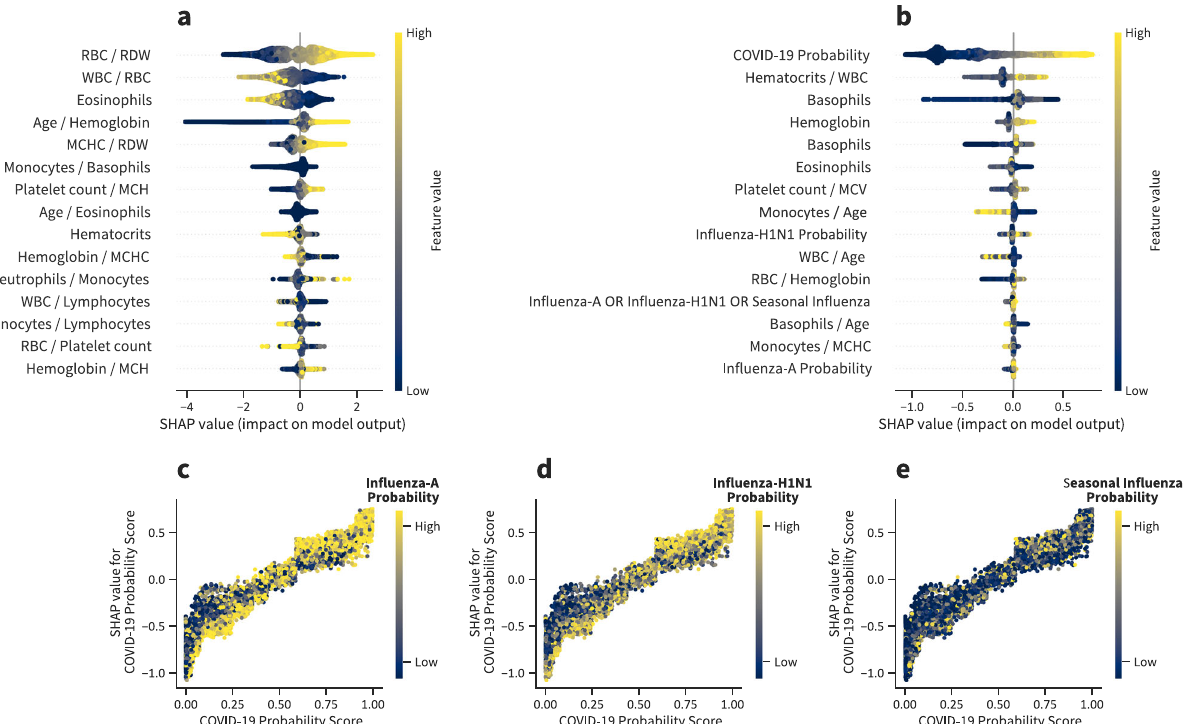
Fig. 7 Learned analyte patterns and disease prediction relationships. a SHAP Summary plot for the COVID-19 specialized model. b SHAP Summary plot for the stacking model, which combines different specialized models and CBC patterns. c Partial dependence plots with the relationship between COVID-19 specialized model's predictions and In fl uenza-H1N1. d Partial dependence plots with the relationship between COVID-19 specialized model's predictions and In fl uenza-A. e Partial dependence plots with the relationship between COVID-19 specialized model's predictions and Seasonal In fl uenza. N = 75923